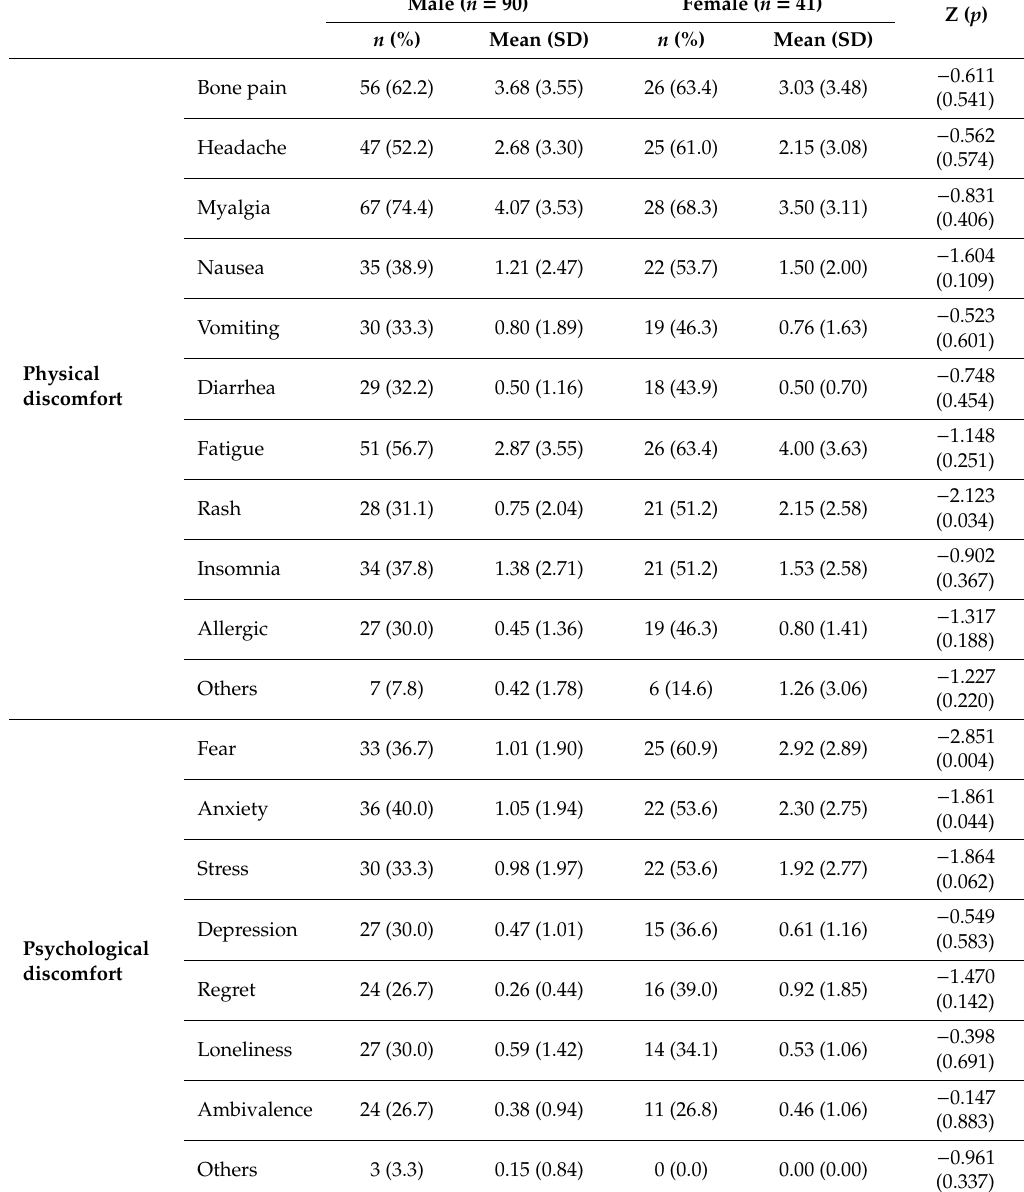
Table 4. Physical and psychological discomfort according to gender (N = 131).